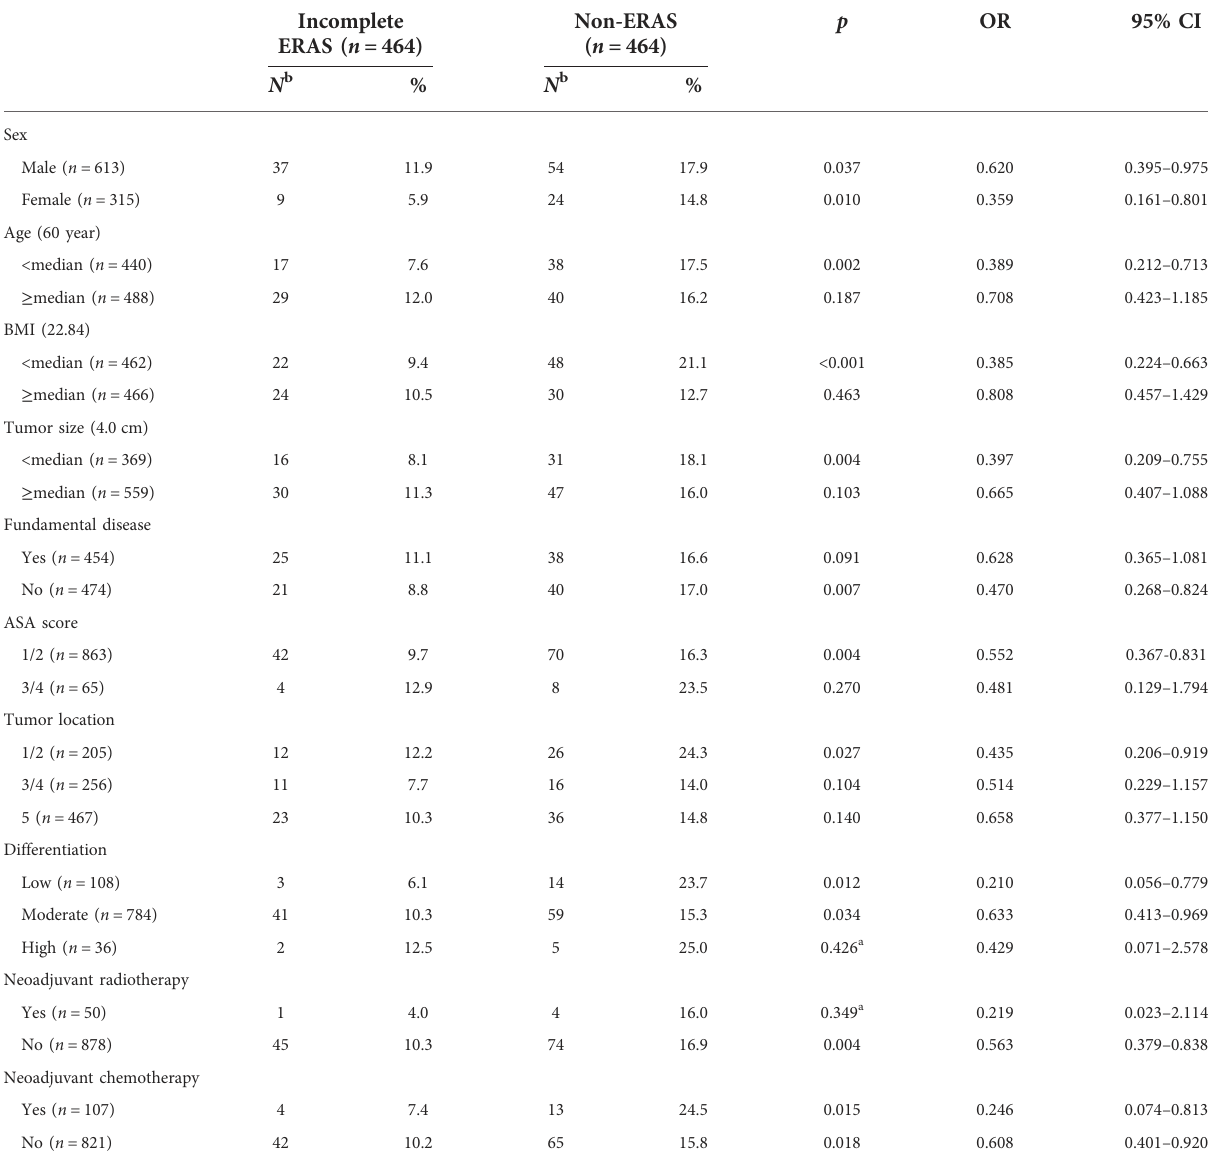
TABLE 5 Subgroup analysis of postoperative